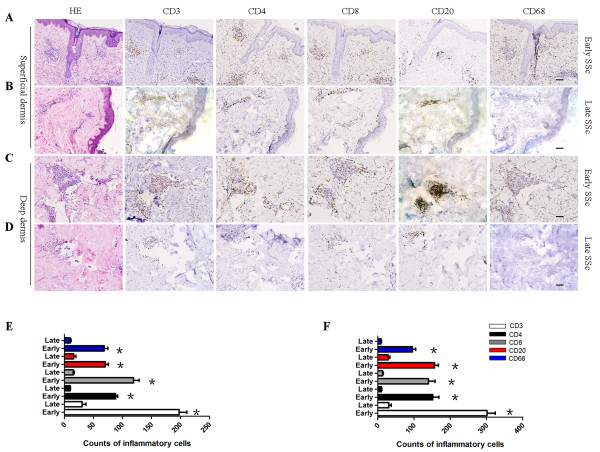
The profile of inflammatory cells in the skin of SSc patients. (A) Hematoxylin and eosin (H&E) staining of consecutive serial sections showing typical pathologic changes of SSc (left panel); lymphocyte infiltration confirmed by CD3, CD4, CD8, CD20, and CD68 immunohistochemical staining in superficial dermis of patients with early SSc (right panels). (B) H&E staining (Left panel); lymphocyte infiltration confirmed by CD3, CD4, CD8, CD20, and CD68 immunohistochemical staining in superficial dermis of late SSc patients (right panels). (C) H&E staining (left panel); lymphocyte infiltration confirmed by CD3, CD4, CD8, CD20, and CD68 immunohistochemical staining in deep dermis of early SSc patients (right panels). (D) H&E staining (left panel); lymphocyte infiltration confirmed by CD3, CD4, CD8, CD20, and CD68 immunohistochemical staining in deep dermis of patients with late SSc (right panels). (E) Counts of CD3+, CD4+, CD8+, CD20+, and CD68+ lymphocytes in superficial dermis of skin (early SSc patients, n = 8; late SSc patients n = 5). (F) Counts of CD3+, CD4+, CD8+, CD20+, and CD68+ lymphocytes in deep dermis of skin (early SSc patients, n = 8; late SSc patients, n = 5). The positive cells in the surface were counted under × 400 magnification, and five randomly selected independent microscopic fields were counted for each sample to ensure that the data were representative and homogeneous. Scale bar, 100 μm.